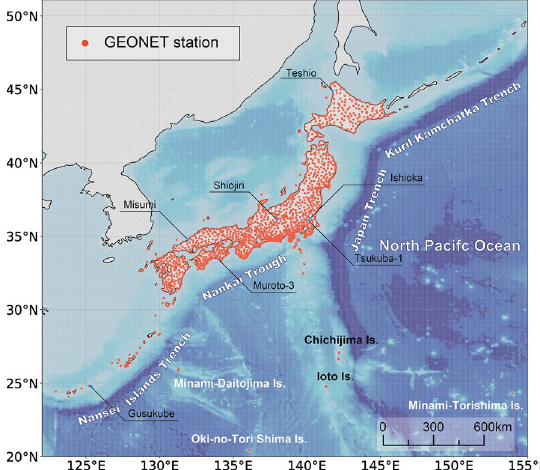
Fig. 1 GEONET station distribution. The bathymetric map was taken from ETOPO1 (NOAA National Geophysical Data Center 2009;